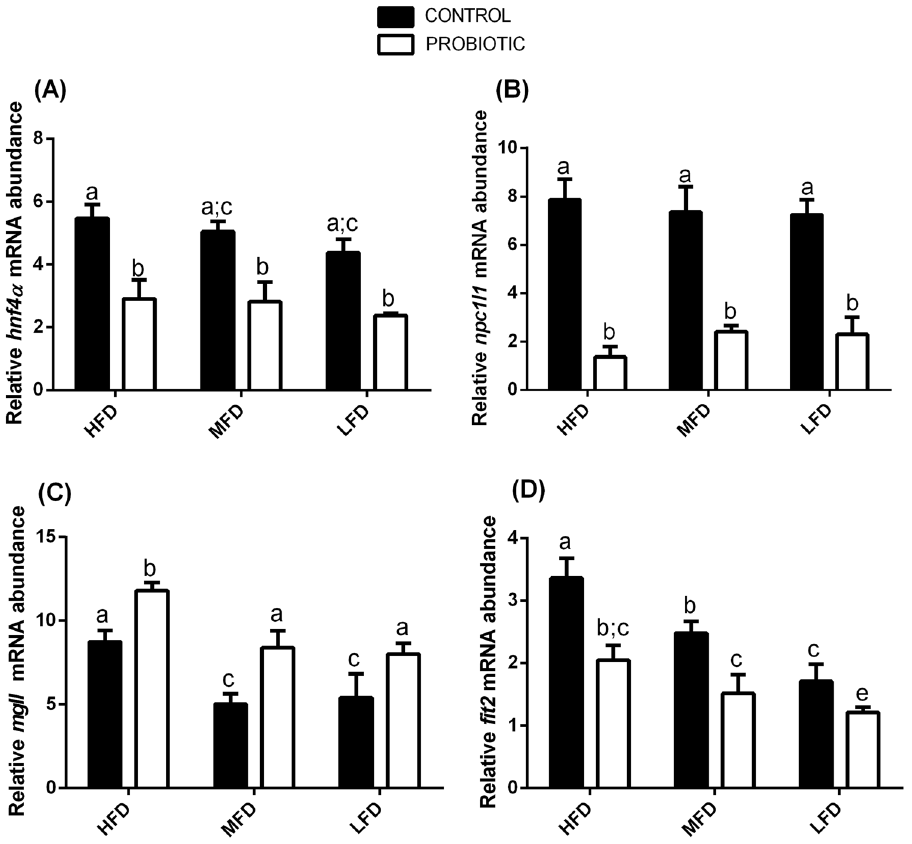
Figure 5. L . rhamnosus modulates the expression of genes involved in lipid metabolism. Relative hnf4a ( A ), npc1l1 ( B ), mgll ( C ) and fit2 ( D ), gene expression normalized against β -act and rplp , in fish fed a HFD-C, MFD-C and LFD-C and fish fed a HFD-P, MFD-P and LFD-P. Assays were performed in triplicate. Values with different superscript letters are significantly different ( p <